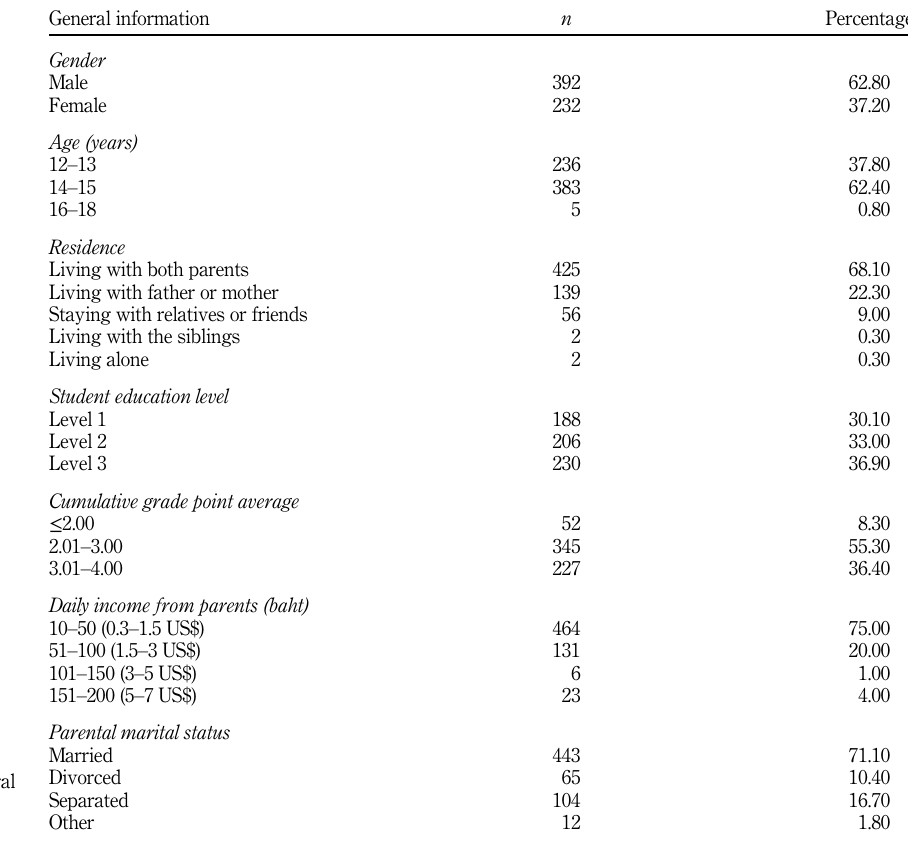
Table 1. Participants ’ general characteristics ( n 5